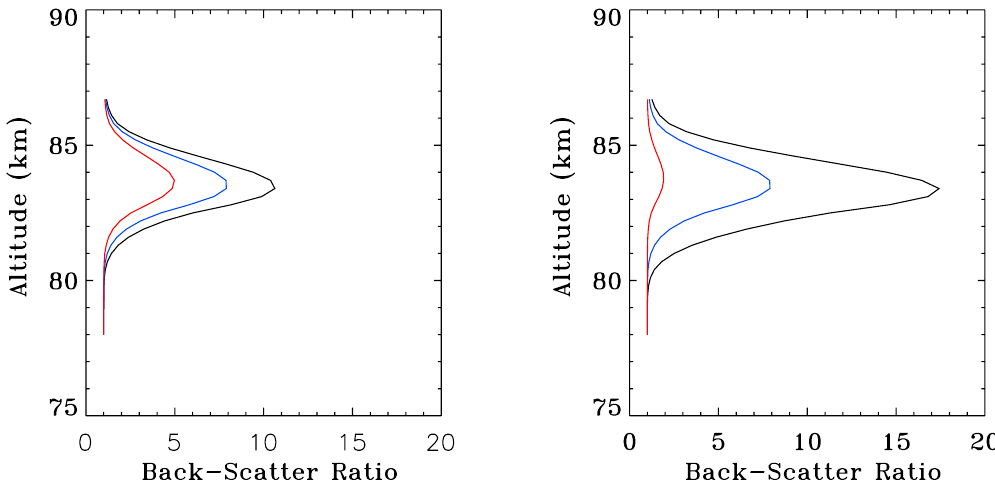
Fig. 2. BSR variability for temperature of 135K and changes of the water vapour mixing ratio as follows: (a) ± 1ppmv; (b) ± 2ppmv. The base-line case, T =135K for water vapour mixing ratio of 4.7ppmv is given by the blue line; the case for water vapour mixing ratio increase is given by the black line, while the case for water vapour mixing ratio decrease is given by the red line.